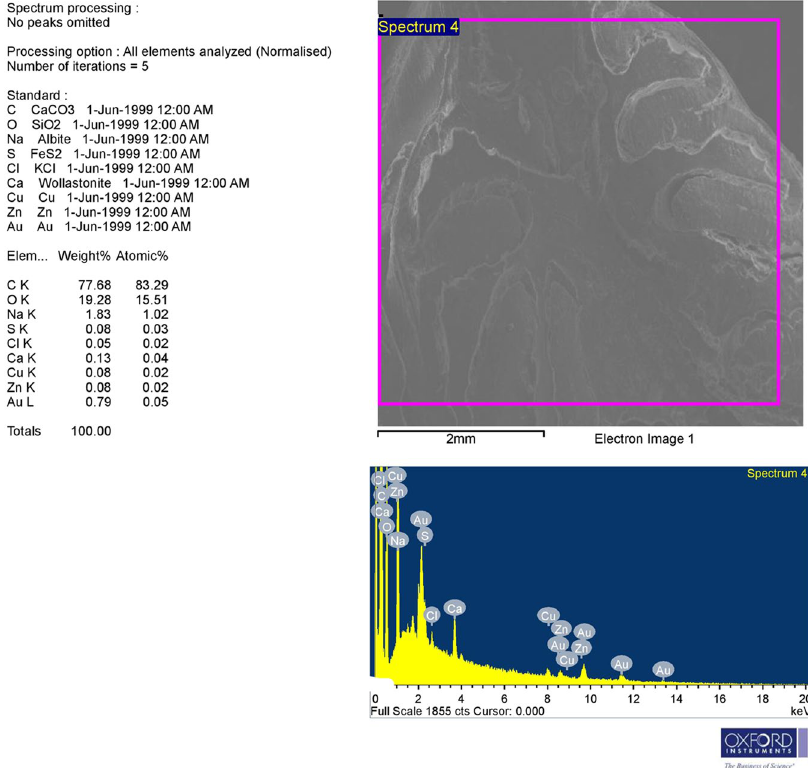
Figure 9. The upper part: SEM image; backscattered electron image displays compositional contrast which results from different elements. The lower part: EDX analysis allows identifying these elements and their relative proportion (atomic % and weight %) by the generation of an x-ray spectrum from the entire scan area of the SEM. The Y-axis depicts the counts of x-rays and the X-axis shows their energy level (KeV). The position of the peaks identifies the elements, while the peaks height helps in the quantification of each element. Here, EDX spectrum showing significant amounts of Au (one prominent peak at 2.2 KeV with other weak peaks).